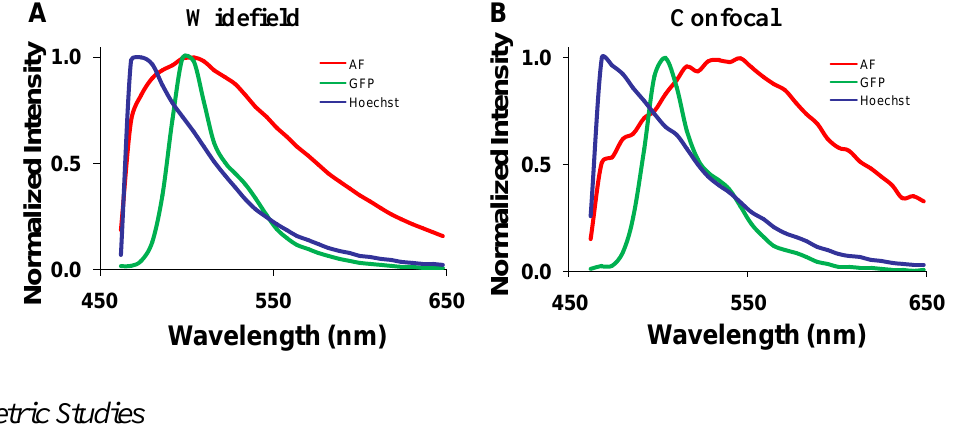
Figure 3. Spectral libraries used for linear spectral unmixing contained three components—lung autofluorescence (AF), green fluorescent protein (GFP), and Hoechst. ( A ) The spectral library acquired using the hyperspectral widefield microscope; ( B ) the spectral library acquired using the hyperspectral confocal microscope. A